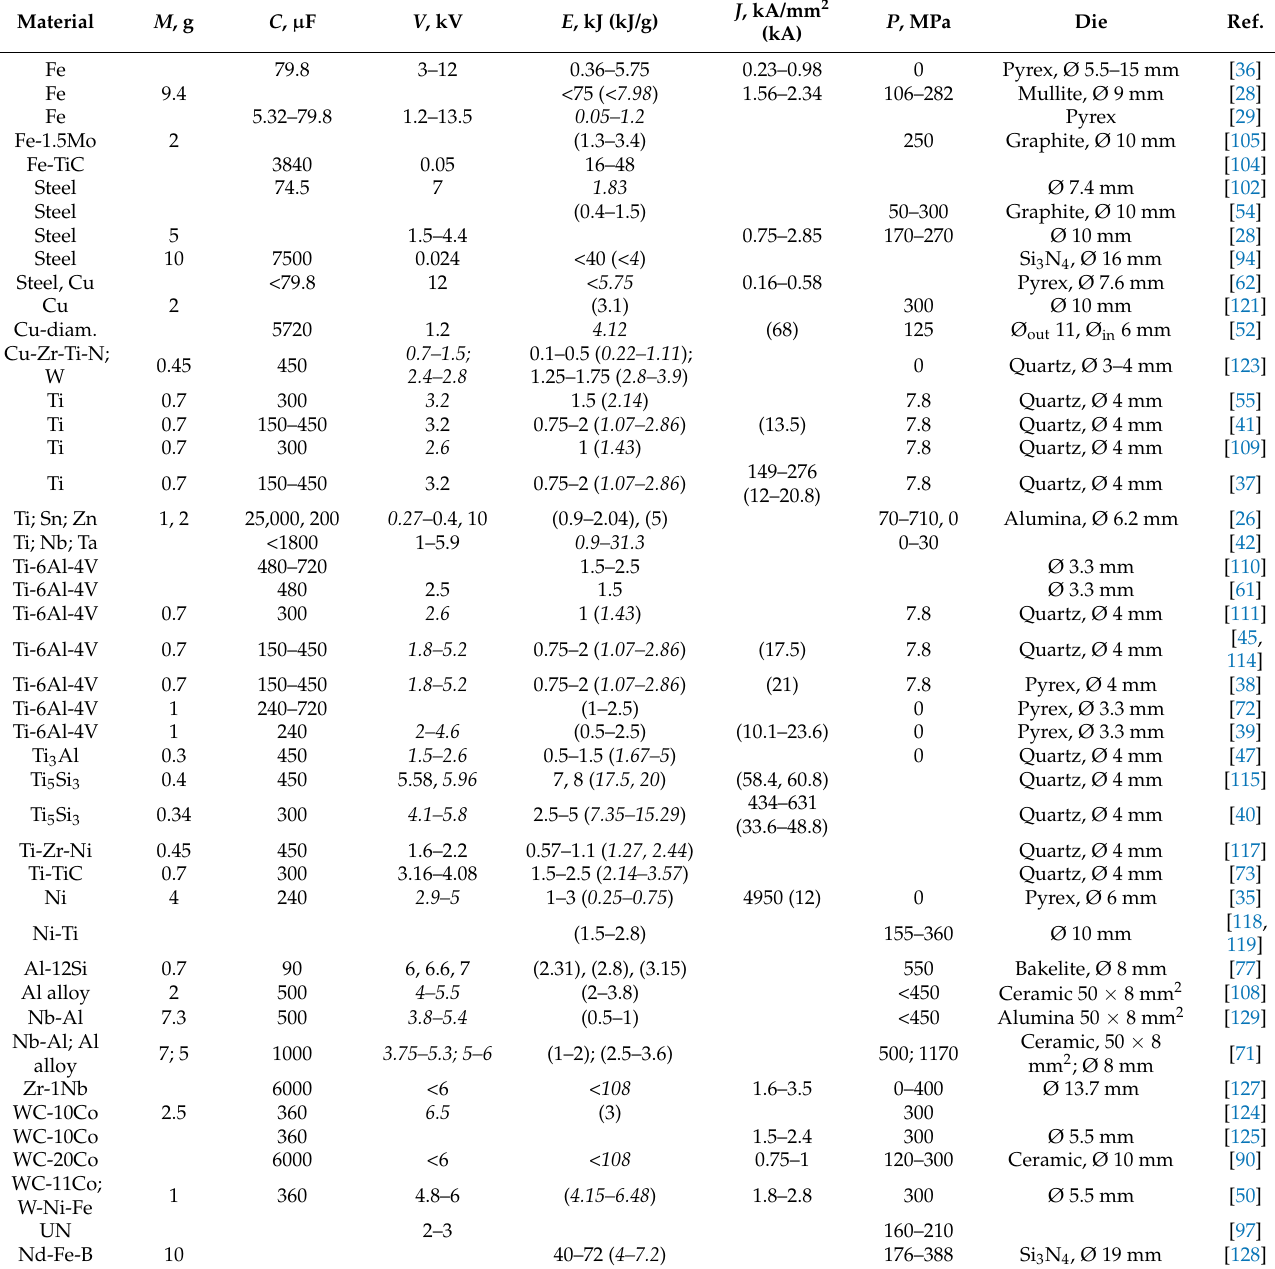
Table 1. Representative EDC processing parameters used by different researchers: mass M , capacitance C , voltage V , energy or specific energy E , current density J or peak intensity, and external pressure P . Values in italics are computed from other values in the